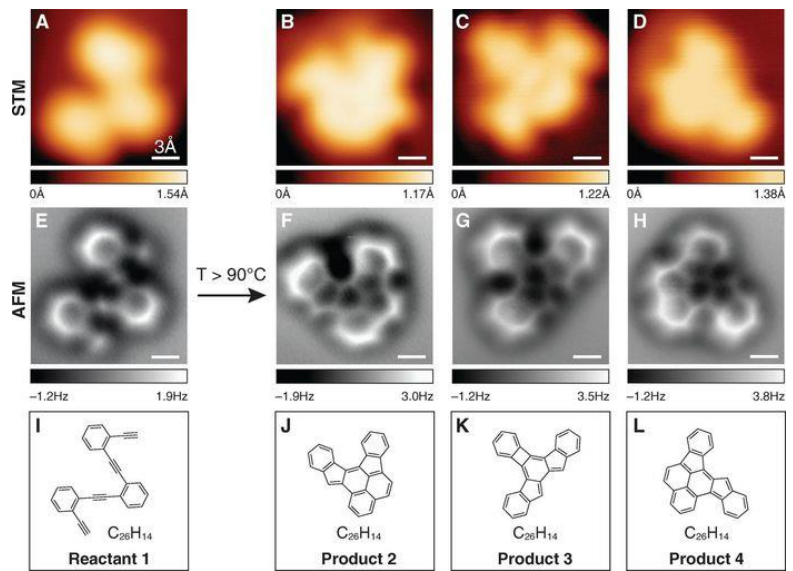
Figure 2. Comparison of STM images, nc-AFM images, and structures for molecular reactant ( 1 ) and products ( 2 , 3 , 4 ). ( A ) STM image of 1 on Ag(100) before annealing. ( B – D ) STM images of individual products 2 , 3 , and 4 on Ag(100) after annealing at T > 90 °C. ( E ) The nc-AFM image of the same molecule (reactant 1 ) depicted in ( A ). ( F – H ) The nc-AFM images of the same molecules (products 2 , 3 , and 4 ) depicted in ( B – D ). ( I – L ) Schematic representation of the molecular structure of reactant 1 and products 2 , 3 , and 4 . Reprinted from Ref. [18] with permission from